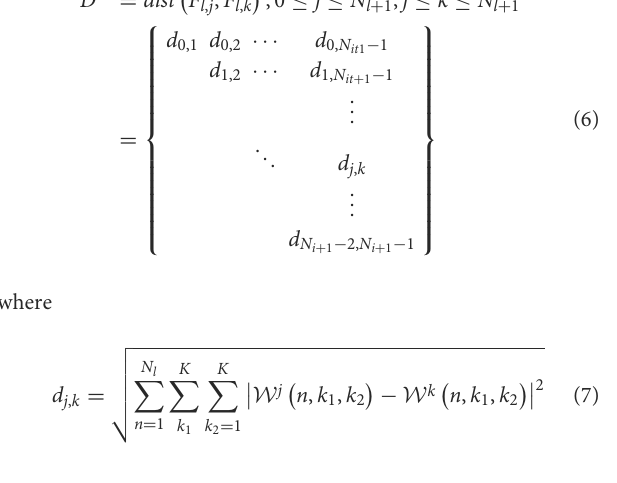
Intuitively, we quantify the similarity of two kernels by Euclidean distance, which is more commonly used in the analyses that need to reflect a difference in dimensions. In addition, Euclidean distance measures the distance between points in multidimensional space and can remember the absolute difference of